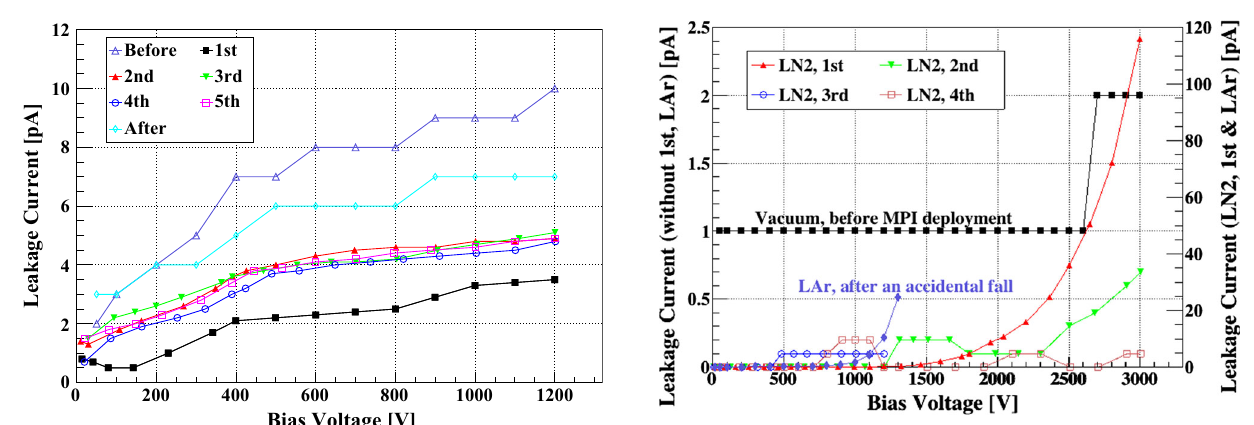
Fig. 8 Leakage current of detector USD-RL as a function of its bias voltage in LN 2 , except for the “Before” and “After” data sets, which weremeasuredinvacuumatUSDbeforeandaftertheMPIdeployment, respectively. The numbers denote thermal cycles in LN 2